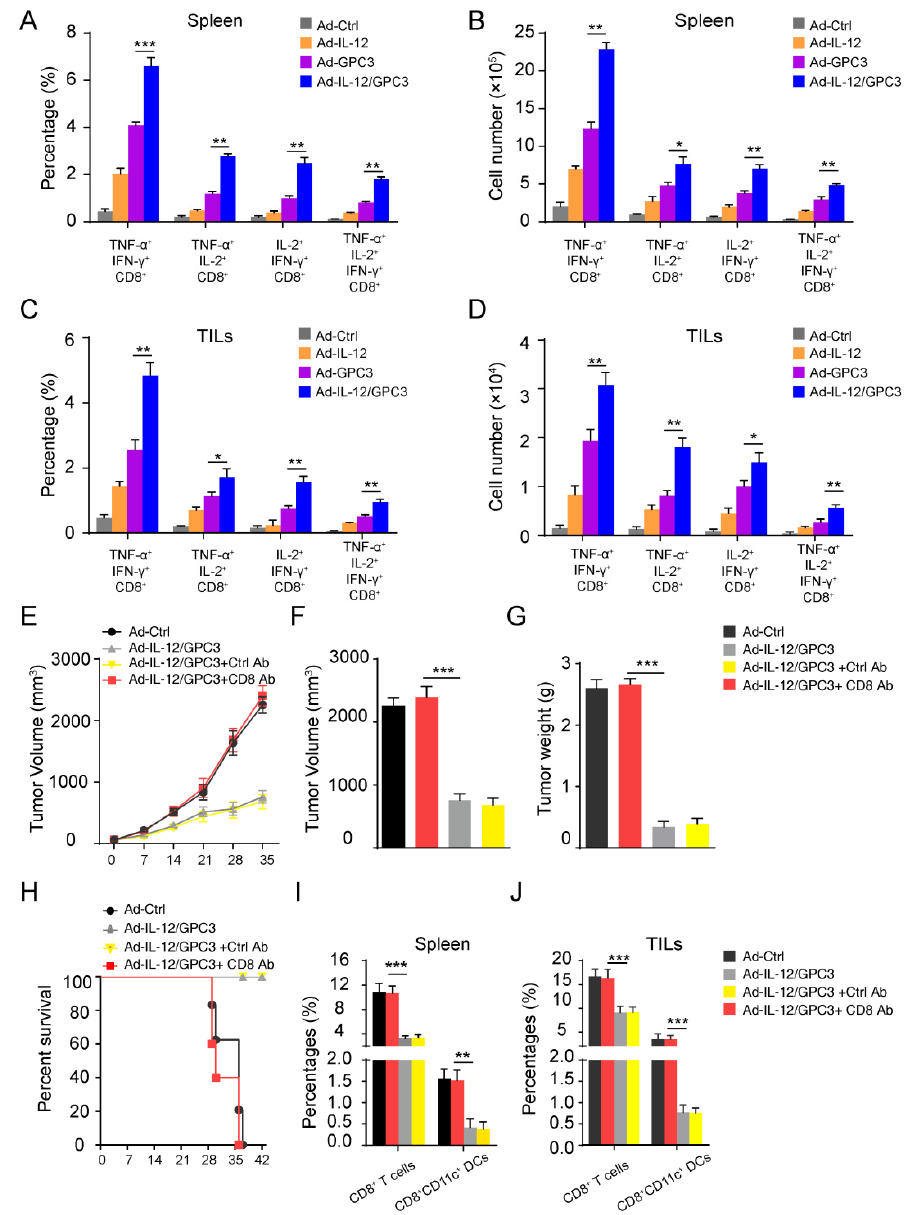
Figure 5. Anti-tumor response induced by Ad-IL-12/GPC3 vaccine was CD8 + T cell-dependent. ( A , B ) The percentages and amounts of cells expressing TNF- α + IL-2 + , TNF- α + IFN- γ + , IL-2 + IFN- γ + , and TNF- α + IL-2 + IFN- γ + by gating on CD8 + T cells from splenocytes stimulated with 10 μ g/mL GPC3 protein for 72 h, with 500 ng/mL ionomycin (Sigma-Aldrich) and 50 ng/mL PMA plus 5 ng/mL BFA for the last 5 h. ( C , D ) CD8 + T cells expressing TNF- α + IL-2 + , TNF- α + IFN- γ + , IL-2 + IFN- γ + or TNF- α + IL-2 + IFN- γ + were detected in the stimulated TILs. In the CD8 depletion group, mice were intraperitoneally injected with 0.5 mg anti-mouse CD8 mAb 2 days before the vaccine’s first administration. The antibody injection was repeated on the 5th and 12th days after the first vaccination. ( E , F ) Mice were sacrificed on the 42nd day after tumor inoculation in Ad-IL-12/GPC3 and Ad-IL-12/GPC3+Ctrl Ab groups, while mice in other groups were sacrificed before the 42nd day due to the heavy tumor burden and tumor volumes in four groups were measured on the 35th day after tumor inoculation. ( G ) Weights of tumor; ( H ) survival rate. ( I , J ) The proportions of CD8 + T cells or CD8 + CD11c + cells were assessed in spleen or TILs. The experiments were performed with five mice per group. Data shown are representative of three experiments. Data, mean ± SD, * p < 0.05, ** p < 0.01, and *** p <